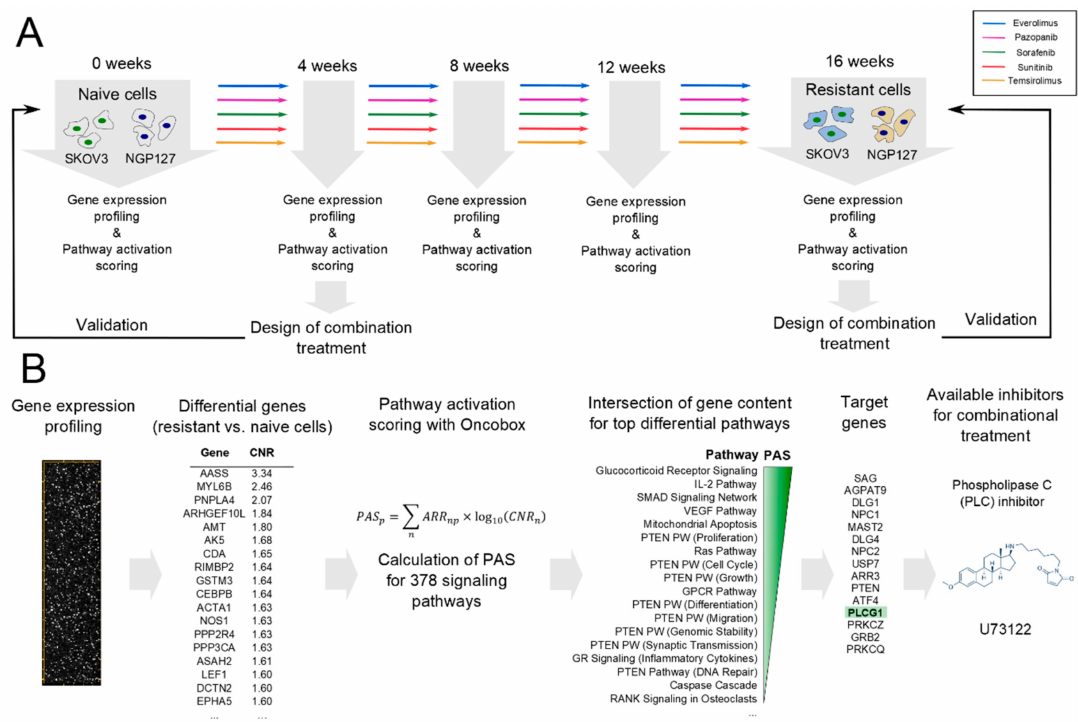
Figure 1. Overall design of the study. ( A ) Adaptation of cell lines to target drugs. ( B ) Bioinformatical pipeline for finding target drugs